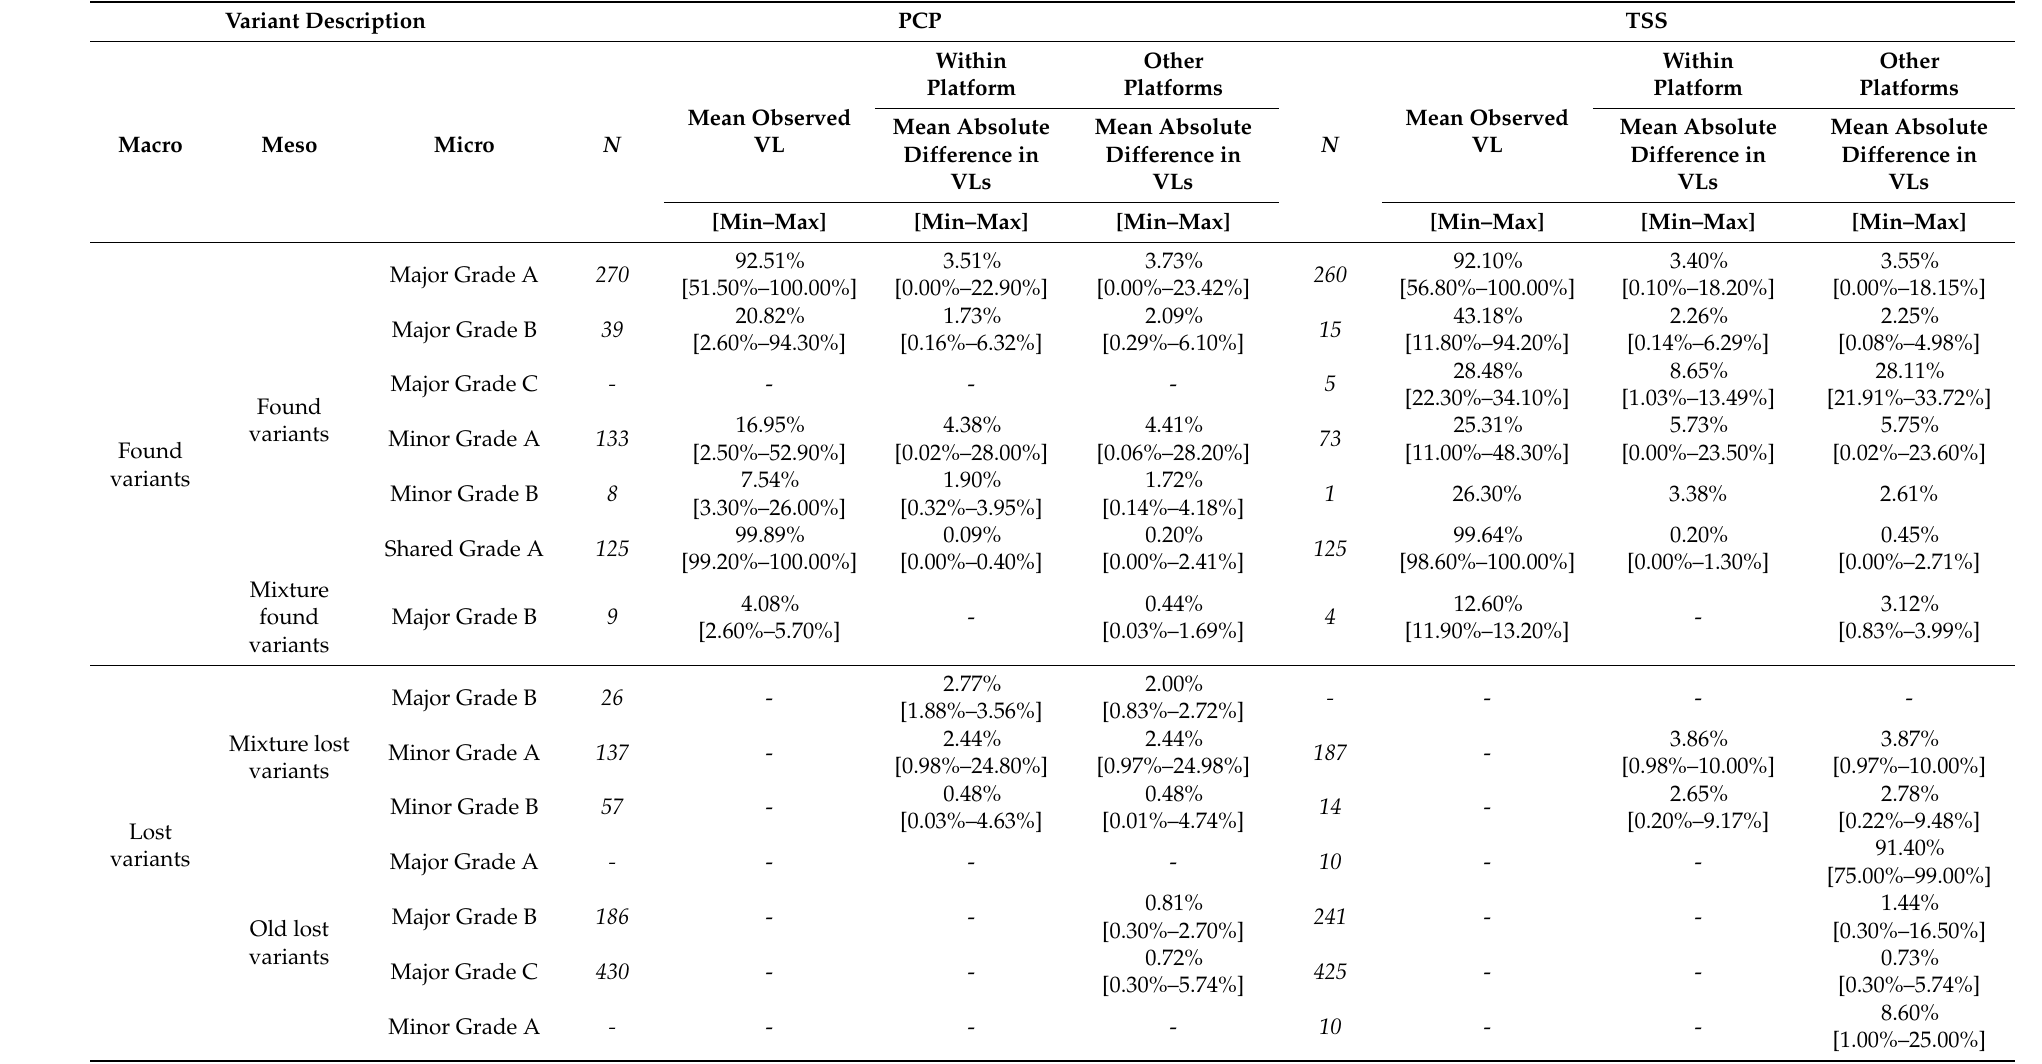
Table A2. Mixture analysis: Distribution of variants with the mutserve